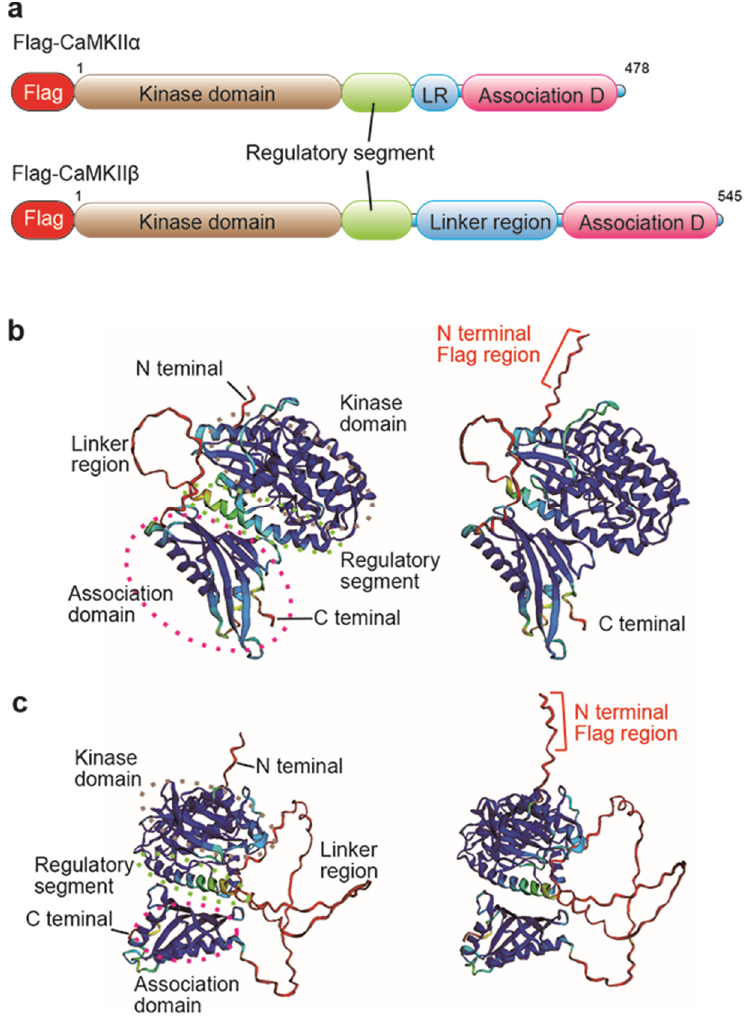
Figure 1. Flag-CaMKIIα and-β protein structures predicted by AlphaFold2. ( a ) Flag-tagged CaMKIIα and CaMKIIβ protein structures with a Flag tag (red), kinase domain (brown), regulatory segment (green), linker region (LR, blue), and association domain (pink). ( b ) 3D structure of CaMKIIα (left) and Flag-CaMKIIα (right) proteins by ColabFold. ( c ). The 3D structure of CaMKIIβ (left) and Flag-CaMKIIβ (right) proteins using ColabFold. The prediction quality as per residue confidence score, pLDDIT, is shown as colors of 3D structure, very high (blue, pLDDT > 90), confidence (light blue, 90 > Plddt > 70), low (yellow, 70 > pLDDT > 50), and very low (red, pLDDT > 50).